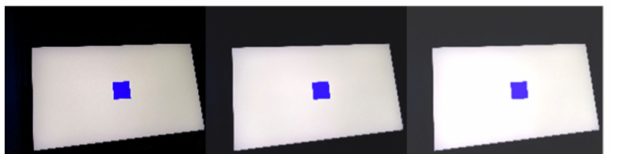
Figure 3. The contrast of three kinds of brightness in the same color